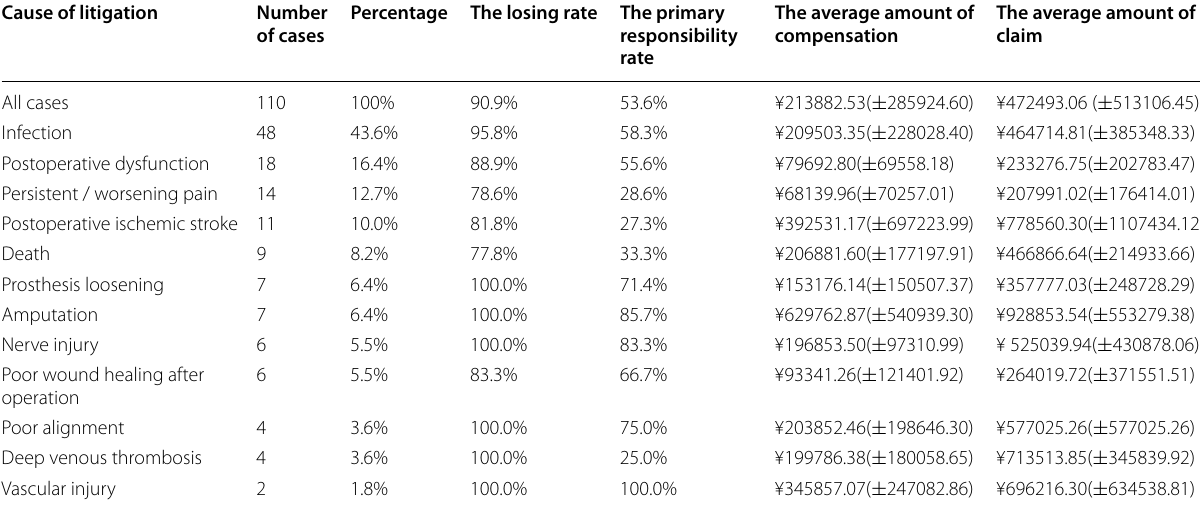
Table 3 The number of various causes of action, the percentage of the total cases, the losing rate, the primary responsibility rate of doctors (50% doctor responsibility 100%), the average amount of compensation and the average amount of claim among all the ≤ ≤ litigation cases of total knee arthroplasty included in the study.